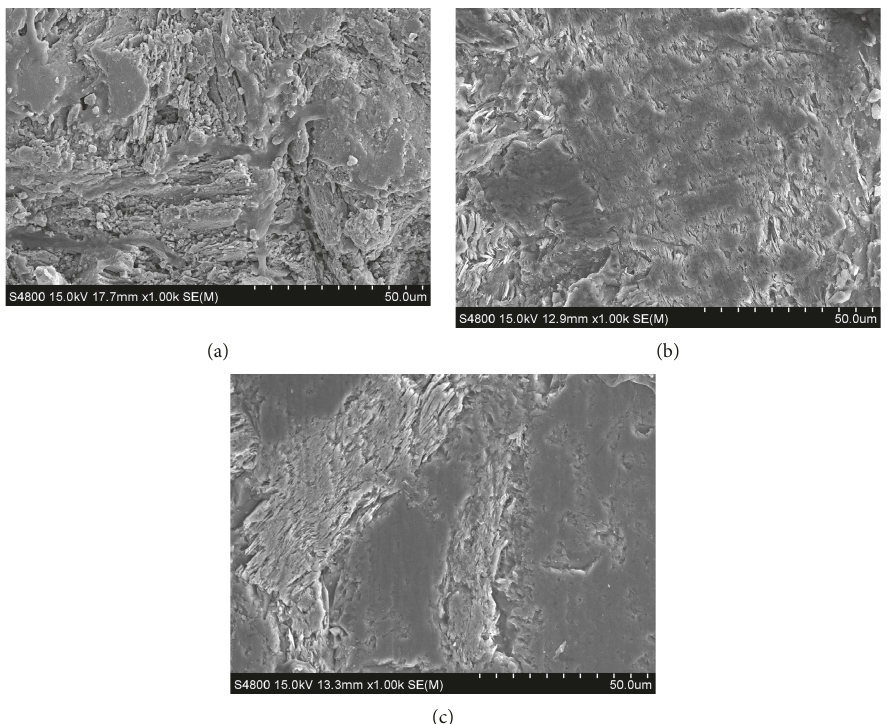
Figure 8: Micromorphology of the granite surface: (a) before the polishing process; (b) after 20 × 10 4 polishing cycles; (c) after 28 × 10 4 polishing